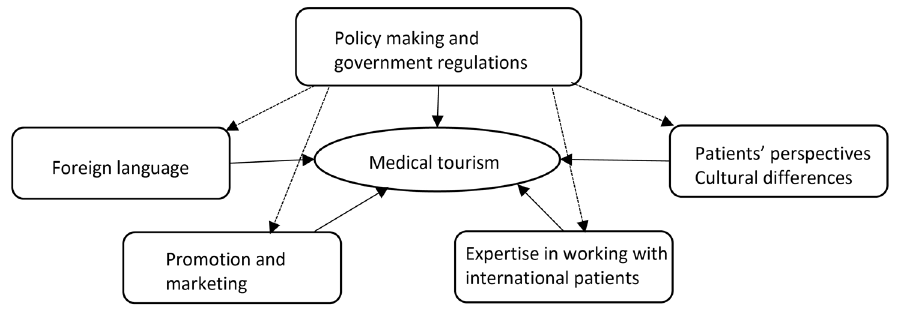
Figure 1. Obstacles of Medical Tourism (adapted from Rokna et al 11